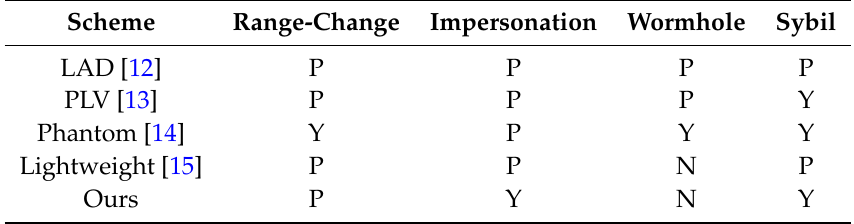
Table 1. Consideration of defense against some known attacks. LAD, location anomaly detection; PLV, Probabilistic Location Verification; P,